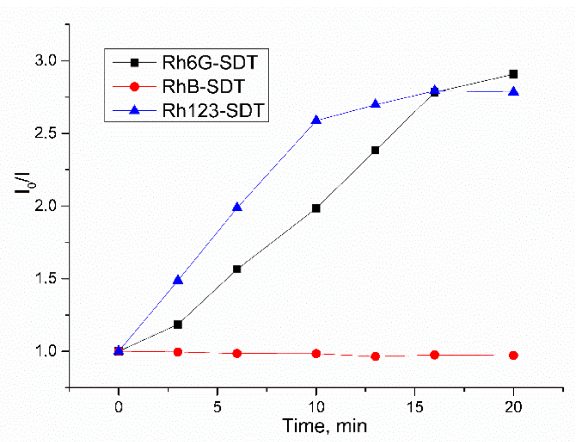
Table 3. Kinetics of the reduction in macrocycles 1 , 2 and 4 in the presence of SDT .